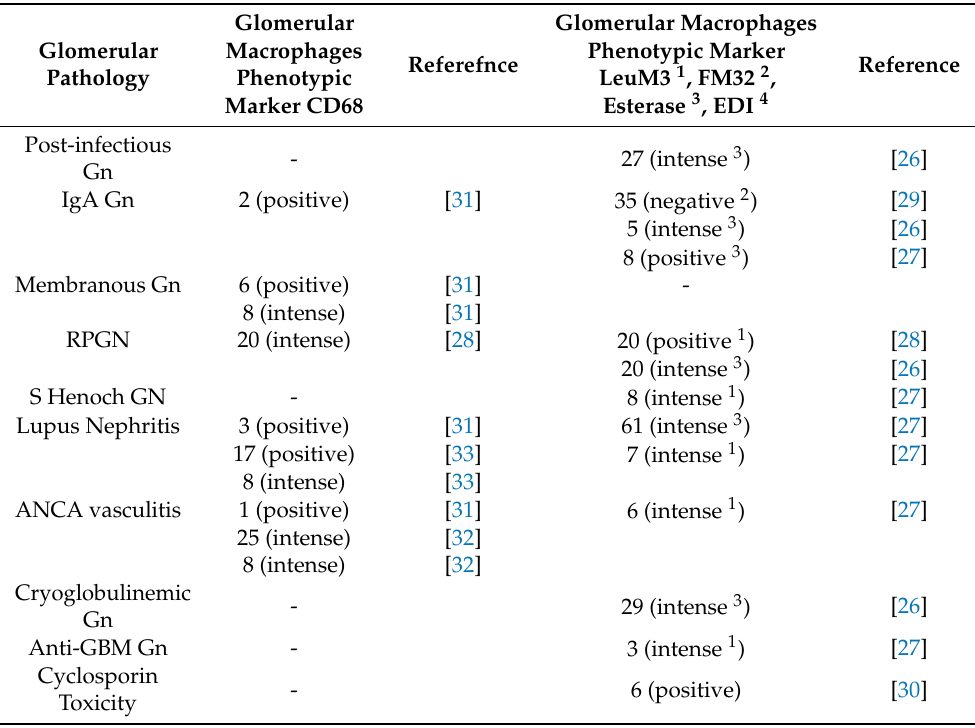
Table 1. PubMed list of publications and total number of patients studied reviewed in the present